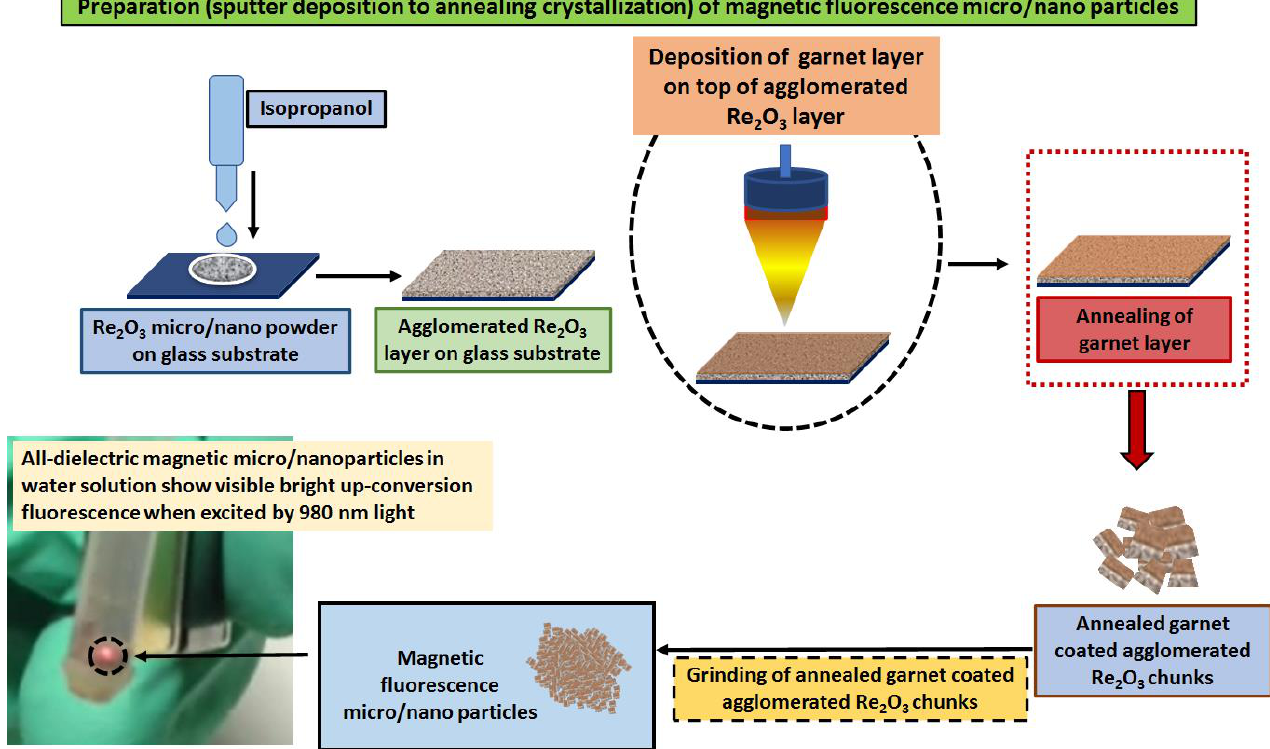
Figure 5. Schematic representation of magnetic fluorescent micro/nanoparticles preparation pro- cess.